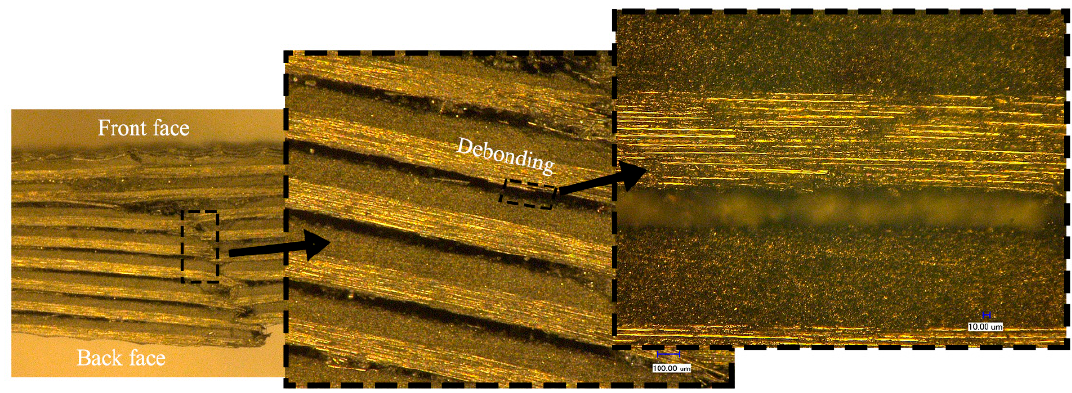
Figure 14. Impact-damaged images of the saturated specimen subjected to the impact velocity of 45 m/s using the 3D-SDDM technique.